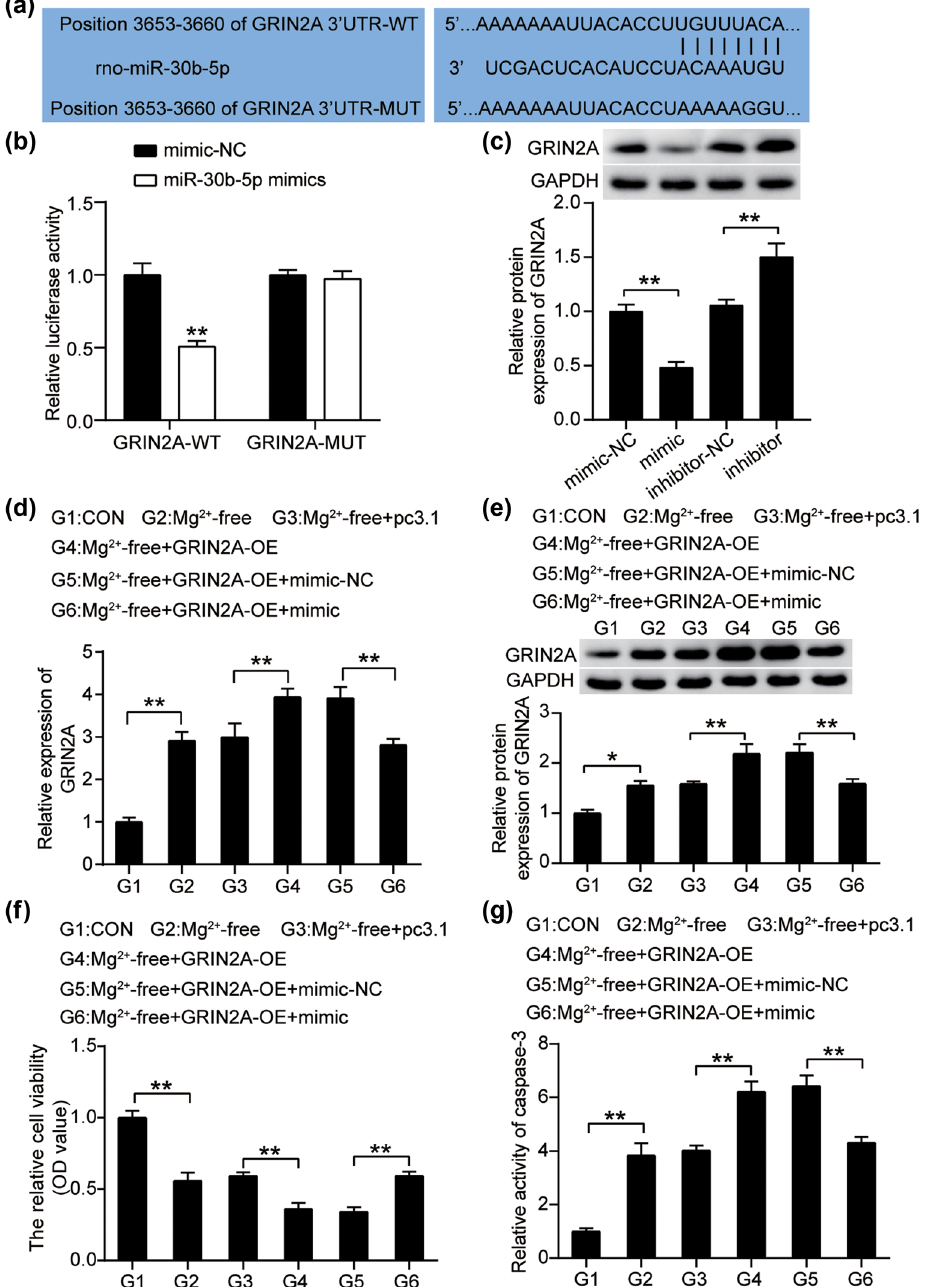
Figure 4: miR - 30b - 5p targets GRIN2A interfering with the magnesium - free condition that induces the growth inhibition of hippocampal neurons. ( a ) Gene structure of GRIN2A indicated the predicted target site of miR - 30b - 5p in its 3 ′ - UTR. ( b ) Luciferase activity was measured in hippocampal neurons following co - transfecting with WT/MUT GRIN2A 3 ′ - UTR plasmid and miR - 30b - 5p with the dual luciferase reporter assay. ( c ) Expression of GRIN2A protein in hippocampal neurons transfected with mimic - NC, miR - 30b - 5p mimic ( mimic ) , inhibitor - NC, and miR - 30b - 5p inhibitor ( inhibitor ) was detected by western blots. ( d ) Expression of GRIN2A in hippocampal neurons transfected with pcDNA3.1 - GRIN2A, pcDNA3.1, miR - 30b - 5p mimic, and miR - 30b - 5p mimic + pcDNA3.1 - GRIN2A before magnesium - free treatment was investigated by RT - qPCR. ( e ) Western blotting analysis of GRIN2A expression in hippocampal neurons in the same groups as ( d ) . ( f ) CCK8 assays determine the cell proliferation in the same groups as ( d ) . ( g ) Caspase - 3 activity measured in the same groups as ( d ) . ** P < 0.001. WT, wild type; MUT,